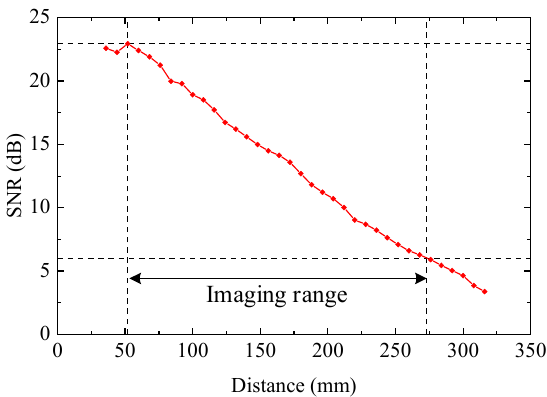
Figure 16. Relationship between the SNR of the echo signal and the imaging distance.